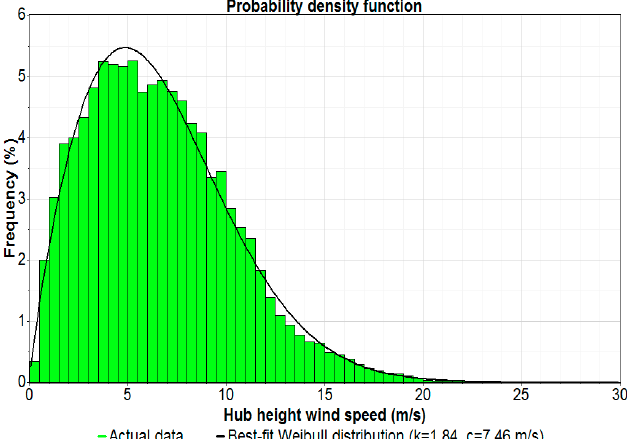
Figure 5. Hub-height wind speed frequency for 12 months.